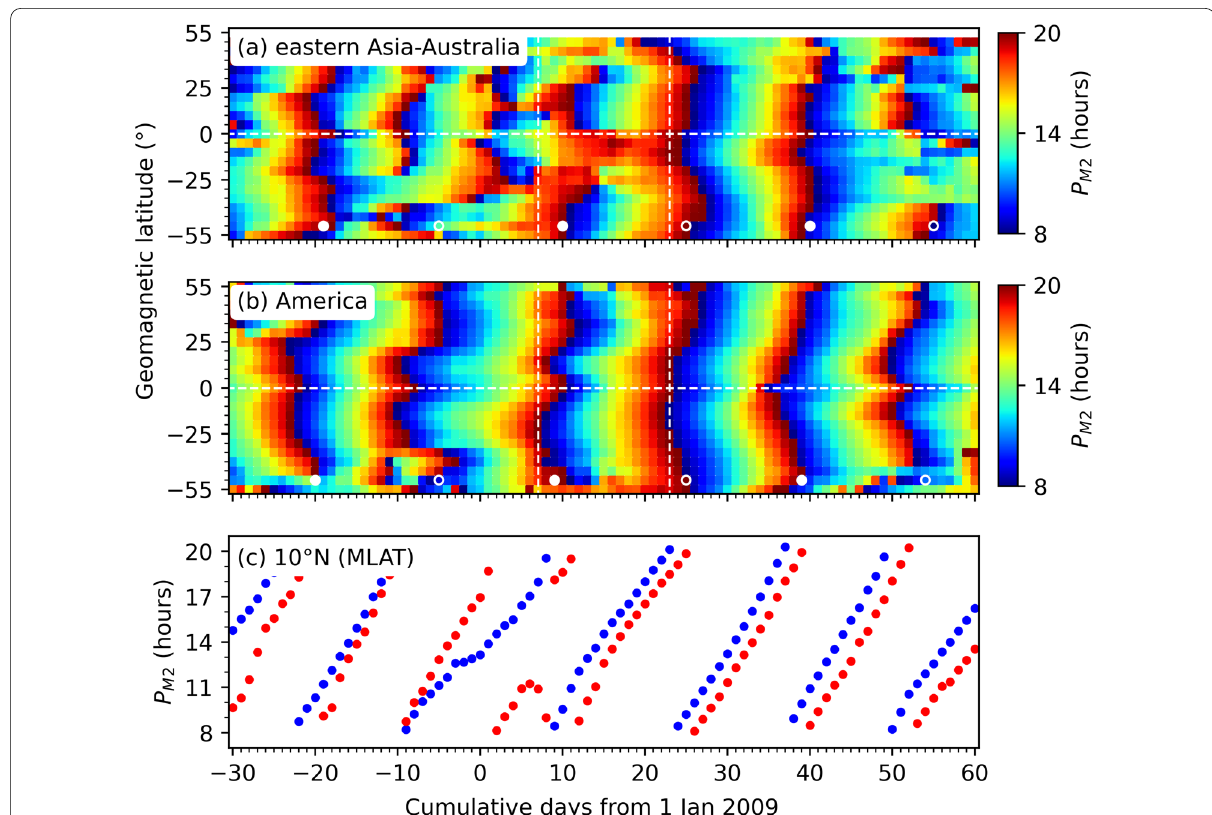
Fig. 7 The variations of P M2 in the a eastern Asia–Australia and b American sectors during the 2009 SSW. The dashed lines are the same as those in Fig. 6. c Gives the P M2 variations at 10°N geomagnetic latitude in the two sectors with red for the eastern Asia–Australia sector and blue for the American